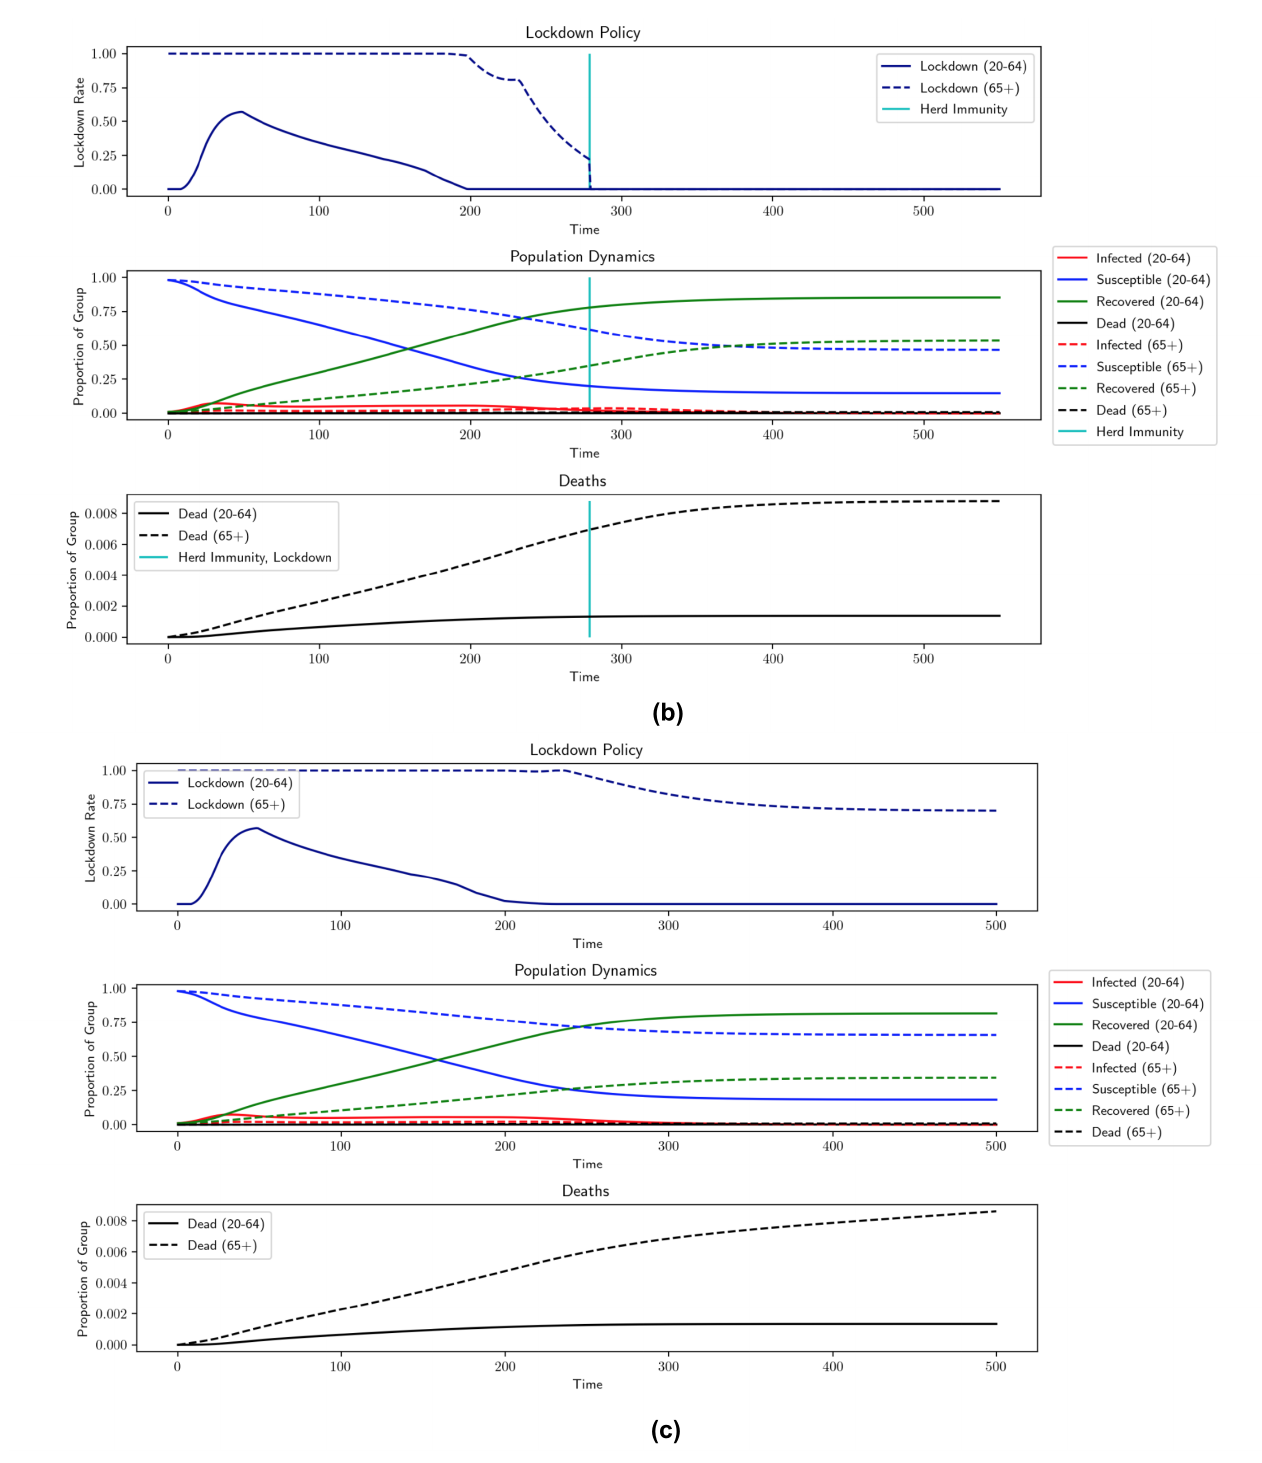
Figure 11. Robustness results for σ (arrival of herd immunity). ρ = 0.75, χ = 10/ r , r = 0.001%, ν = 0.67, α L = 10 − 5 , α I = 1, α E = 0.42, η = 10, F = 1, h = 0.4. ( a ) Herd immunity = 65%, output loss: 7.8084%, total deaths: 0.2948%; ( b ) herd immunity = 70%, output loss = 7.8496%, total deaths = 0.2724%; ( c ) herd immunity = 75%, output loss: 7.967%, total deaths: